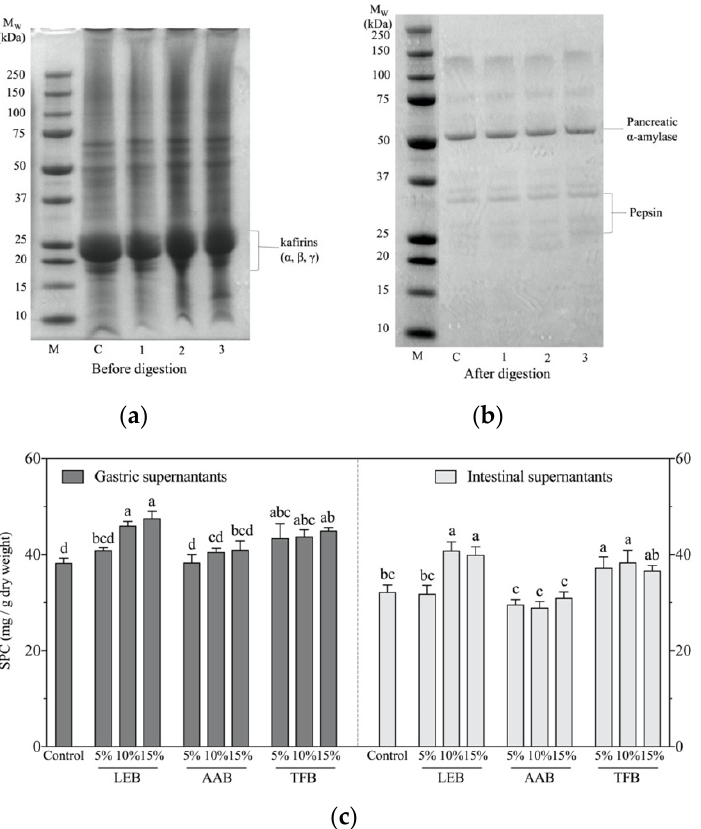
Figure 1. SDS-page analysis of sorghum biscuits enriched with mushroom powder (15% substitution) ( a ) before and ( b ) after gastrointestinal digestion. ( c ) Soluble protein content (SPC) of biscuits after in vitro gastrointestinal digestion. (M—marker; C—control biscuit; 1—15% L. edodes biscuit; 2—15% A. auricula biscuit; 3—15% T. fuciformis biscuit). Error bars represent standard deviation (n = 3). Columns with different letters are significantly different within the same chart ( p < 0.05). LEB— L. edodes biscuit; AAB— A. auricula biscuit; TFB— T. fuciformis biscuit.